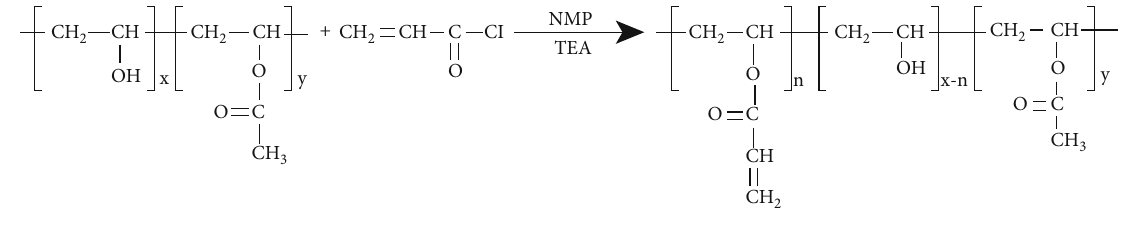
Figure 12: Synthesis diagram of UV-PVA [56].